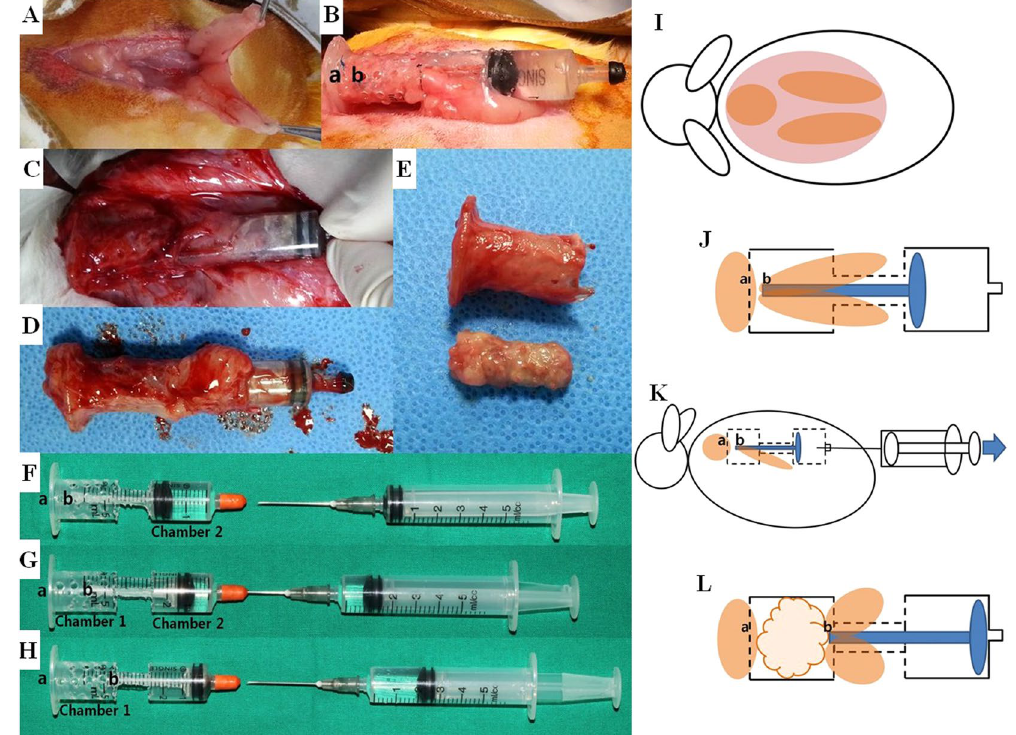
Figure 4. Adipose tissue formation using a distraction technique. Two fat flaps are elevated on the dorsum of the cervical area ( A ), inserted into the chamber, and the tips of the flaps are placed at point (b) for dynamic distraction. A counter fat tissue is sutured at point (a), the fixed part of the chamber ( B ). Distraction is performed for an assigned period, and the chamber with adjacent tissue is harvested ( C , D ). Newly-generated adipose tissue is carefully separated from the chamber ( E ). In the distraction chamber model, fat tissues fixed at points (a) and (b) points are in contact with each other ( F ). Distraction is performed through gradual extraction of saline solution from chamber 2 ( G ). As point (b) recedes from point (a), chamber 1 expands ( H ). Schematically, two fat flaps are elevated following subcutaneous dissection ( I ). The flaps are inserted into the chamber, and the tips of flaps are placed at point (b) for dynamic distraction. A counter fat tissue is sutured at point (a), the fixed part ( J ). The entire distraction chamber is inset in the subcutaneous layer, and distraction is performed using a syringe ( K ). Newly-generated tissue can be observed between points (a) and (b) after a consolidation period ( L